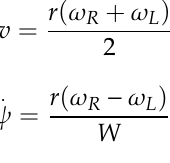
Figure 4. Shared control system concept.